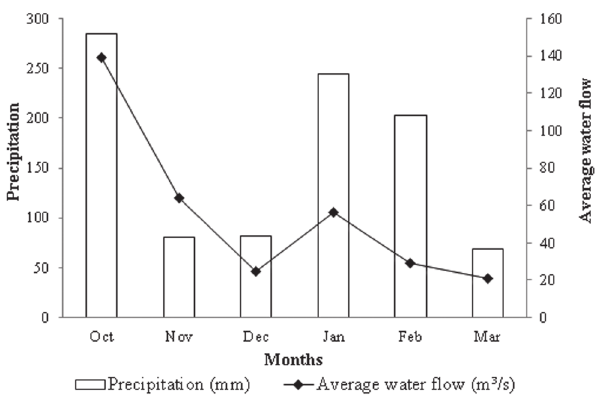
Fig. 5. Average flow and precipitation ratings registered in the Peixe River, from October 2011 to March 2012. Source: Consórcio de Itá.